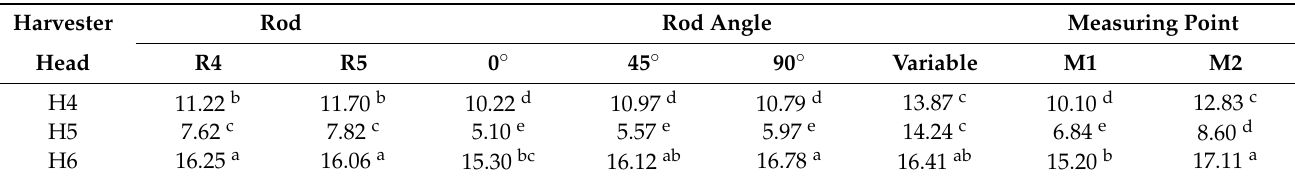
Table 6. Acceleration total values (m/s 2 ) with harvester heads H4-H6 (mean separation by Kruskal–Wallis test for each interaction: means with the same letter are not statistically different at p = 0.05 level).